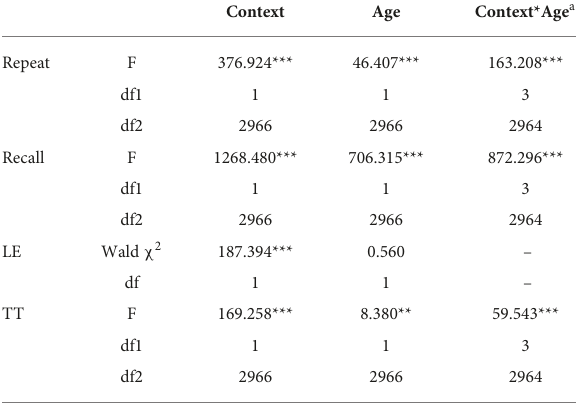
TABLE 1 Fixed effects of context, age group, and interaction effects to RRT